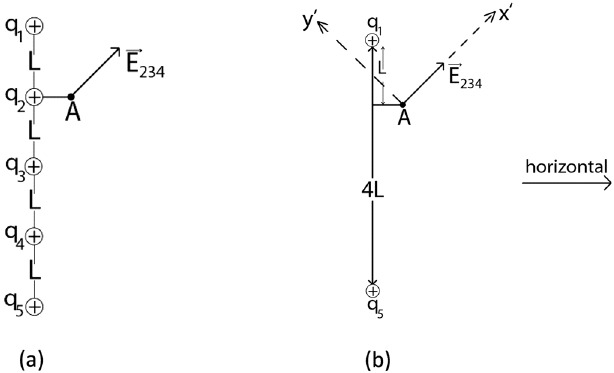
FIG. 4. A schematic diagram from the tutorial designed to help students learn to transition from the case of the electric field due to a discrete distribution of equidistant identical charges in a straight line to the field due to a continuous charge